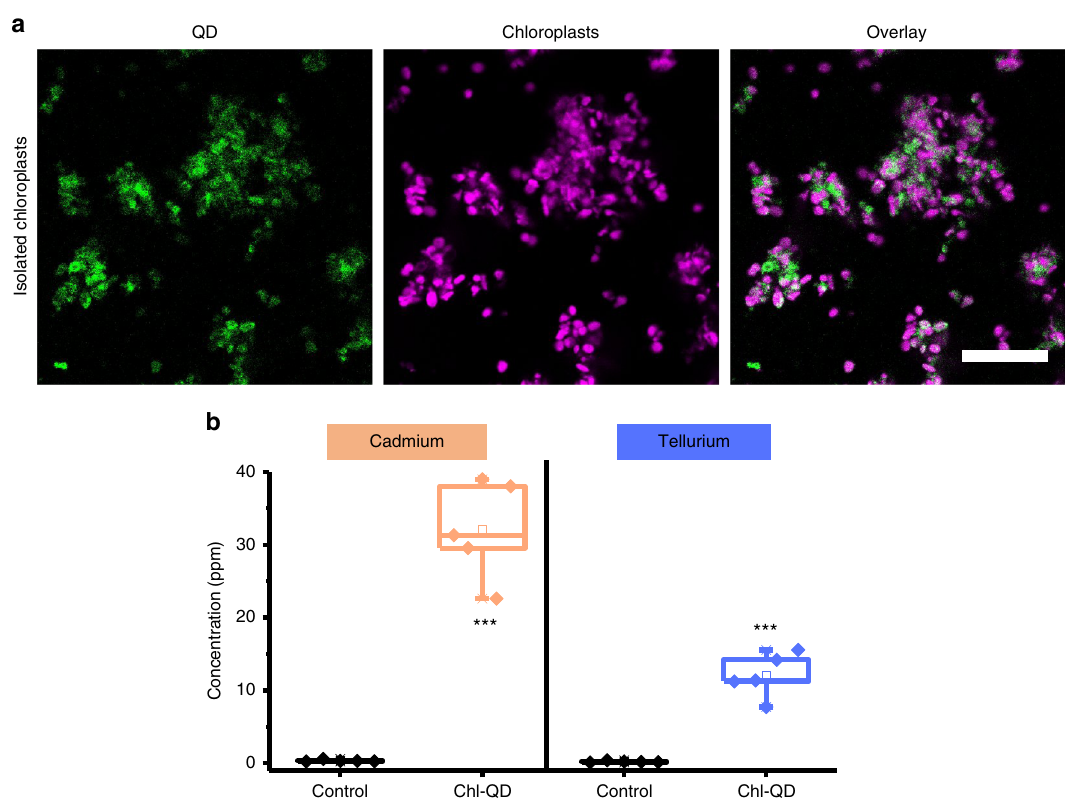
Fig. 4 Detection of quantum dots in isolated chloroplasts by confocal microscopy and inductively coupled plasma mass spectrometry (ICP-MS). a Confocal fl uorescence microscopy images of isolated chloroplasts that were targeted in vivo with CdTe quantum dots functionalized with a chloroplast guiding peptide (Chl-QD). b ICP-MS elemental analysis of cadmium and tellurium in isolated chloroplasts from plant leaves exposed to Chl-QD ( n = 5) and controls ( n = 5) in fi ltrated with TES buffer. Scale bar, 50 μ m. Box plot error bars represent standard deviation, boxes are the interquartile range from the fi rst to the third quartile with squares as the medians, and horizontal line represents the mean. Statistical comparison was performed by independent samples t -test (two tailed). *** indicates P <